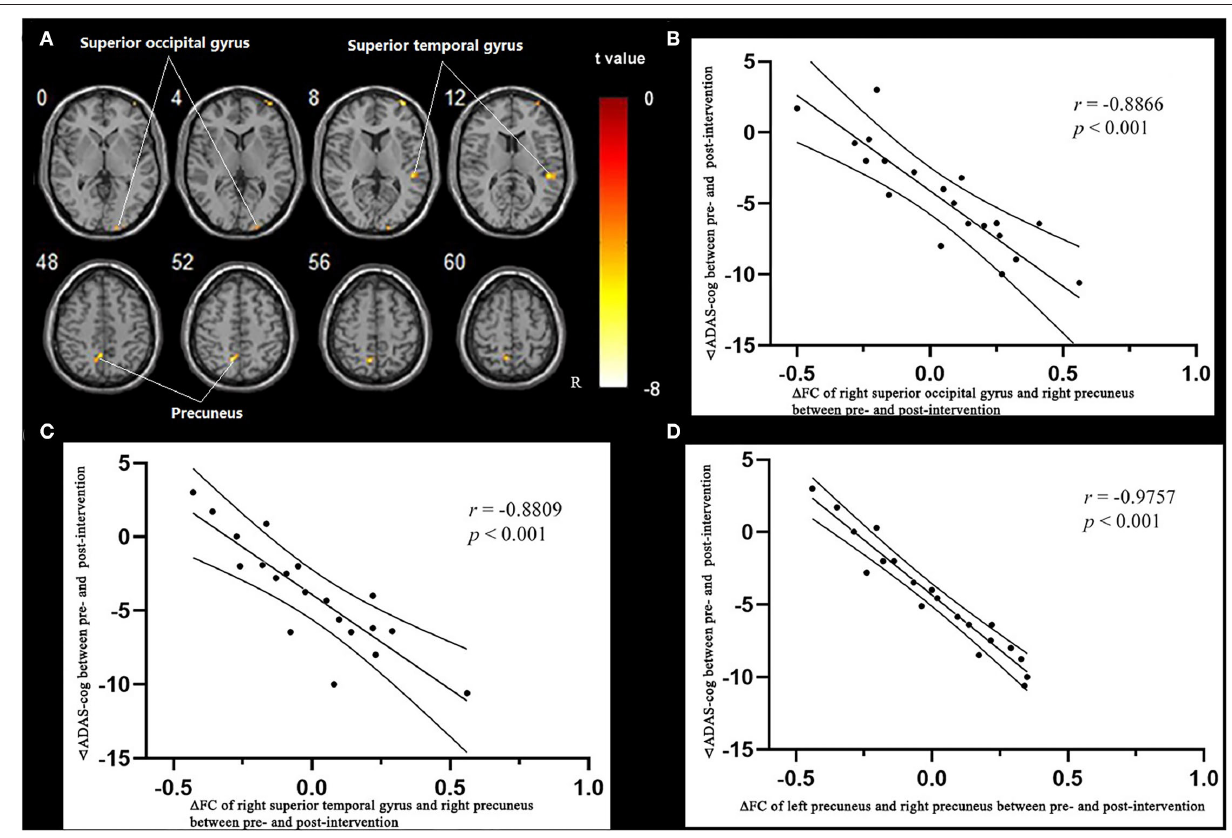
Frontiers in Neurology | www.frontiersin.org